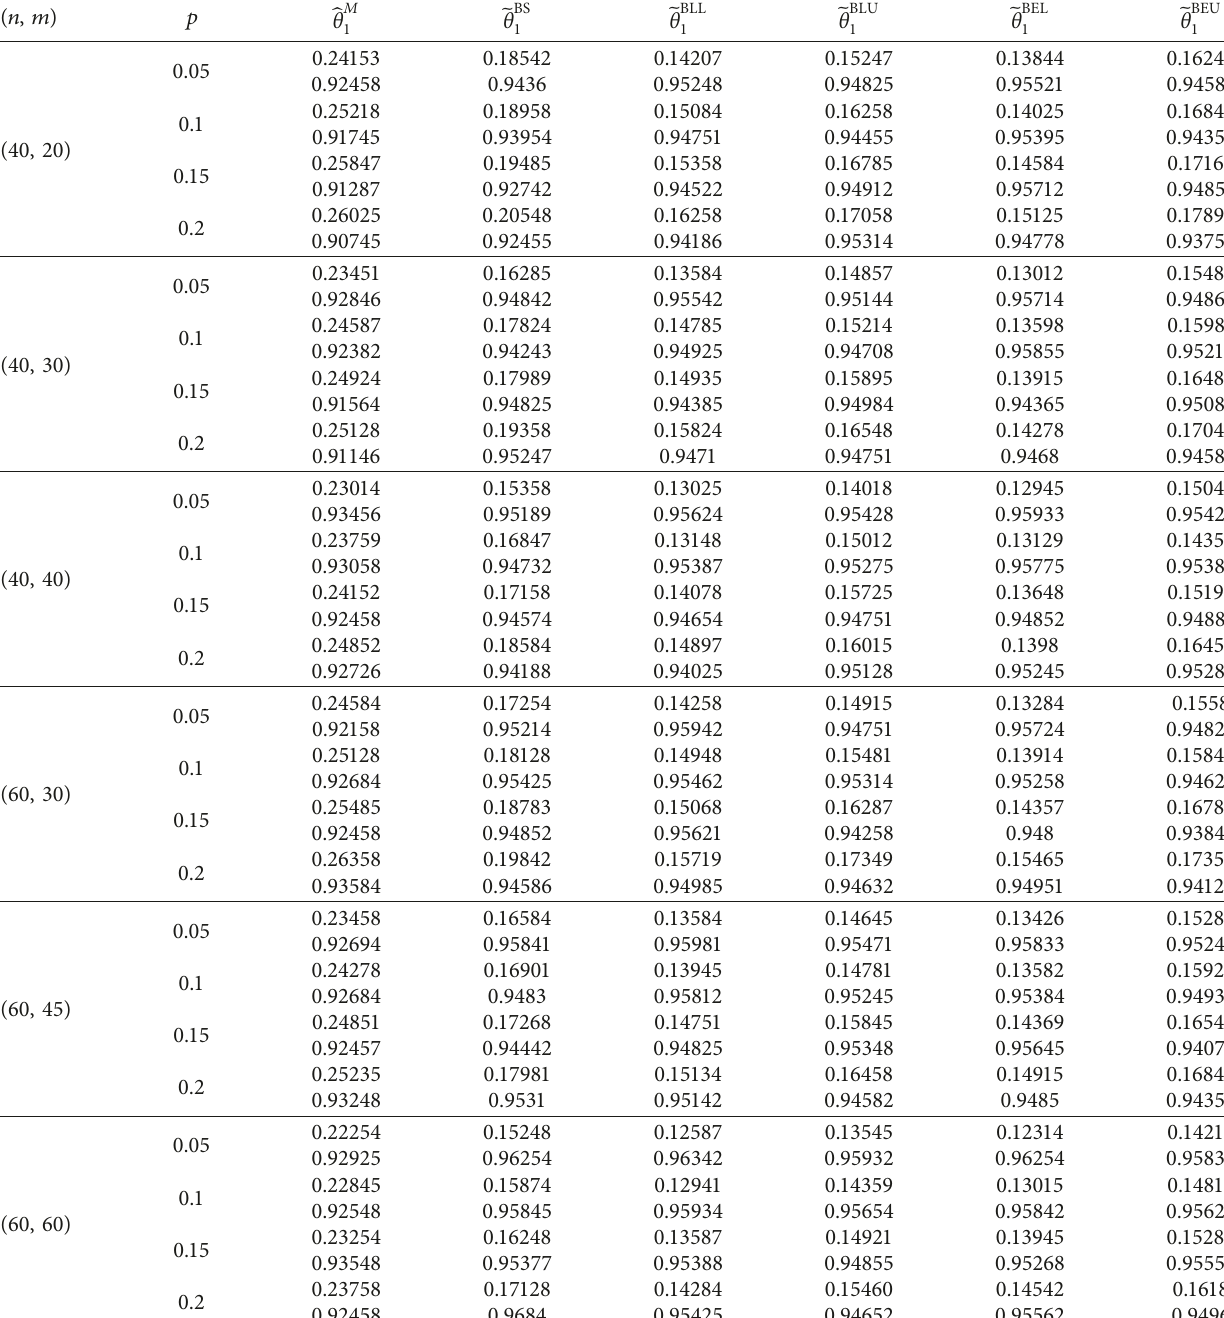
with their coverage probability of different p and m for n 1